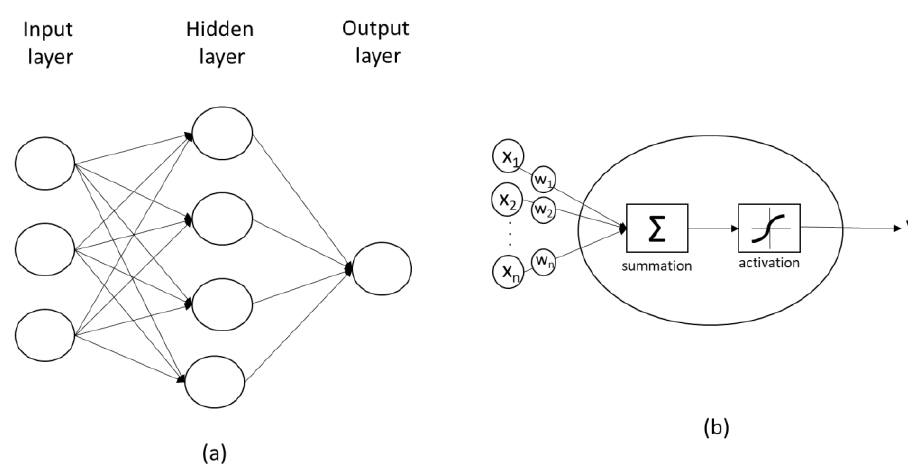
Figure 1. Schematic of ( a ) an ANN and ( b ) a single neuron.